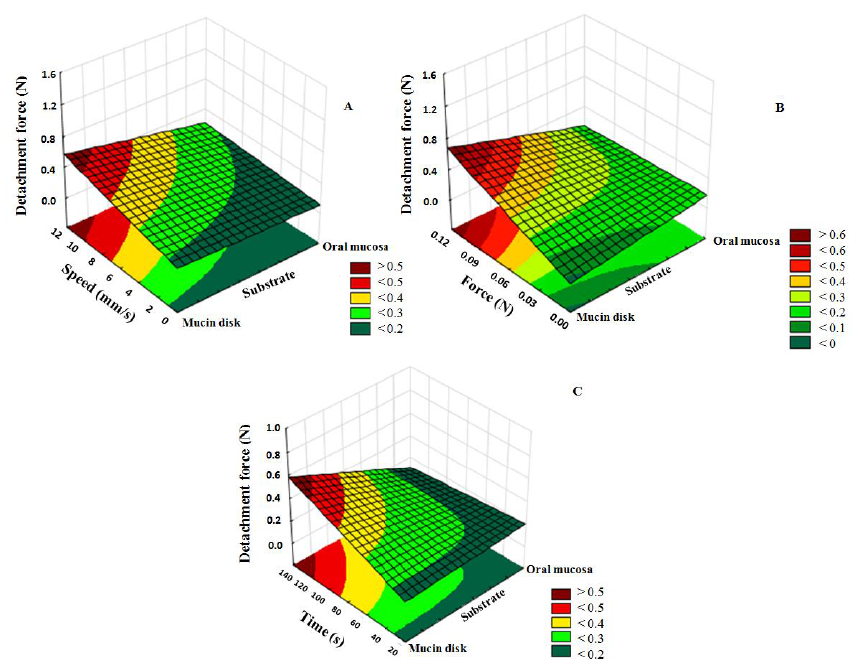
Figure 3. Response surface plots of the detachment force (F adh ) using mucin disk or oral mucosa influenced by some factors: ( A ) speed of probe ascent (mm/s); ( B ) applied force (N); ( C ) analysis time (s).